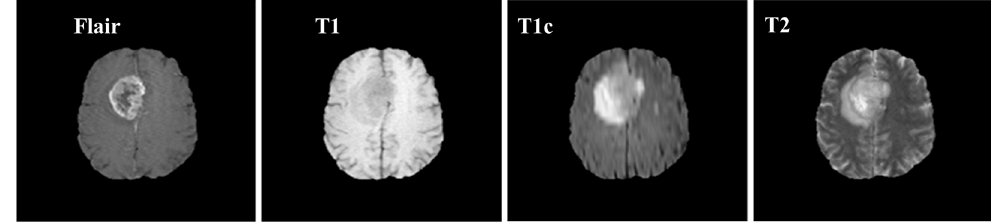
Figure 6. Sample MR images of T1, T2, T1c and Flair modalities. Table 2. Summary of Acquired BraTS MRI Dataset.